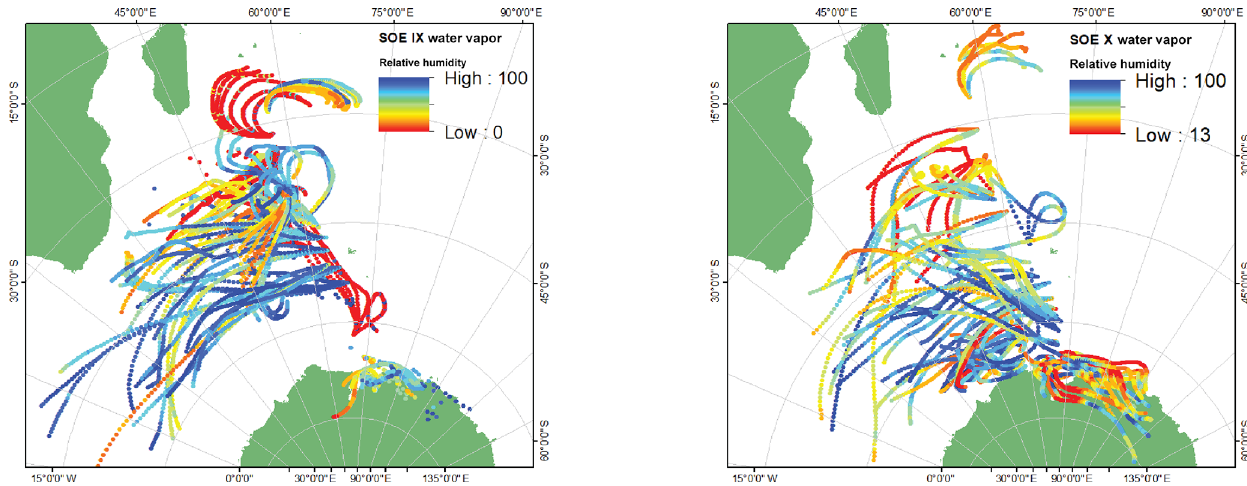
Figure 3. The 72h back trajectories calculated using HYSPLIT with Reanalysis R-2 data as forcing. The trajectories shown are for three heights: surface, 500 and 1500m above the mean sea level, and the colors depict the variation in relative humidity along the trajectories.